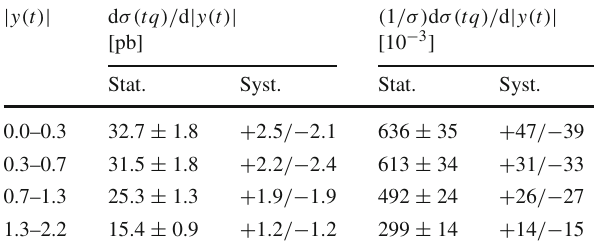
Table 20 Absolute and normalised unfolded differential tq production cross-sections as a function of | y ( t ) | at parton level | y ( t ) |